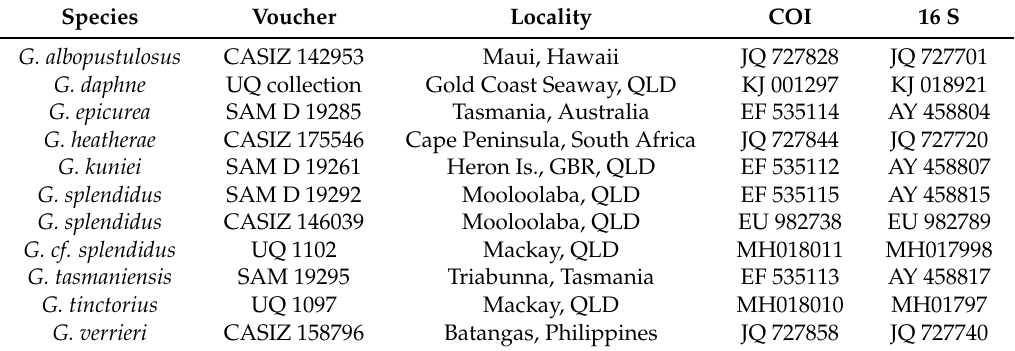
Table 1. Species of Goniobranchus included in the phylogenetic